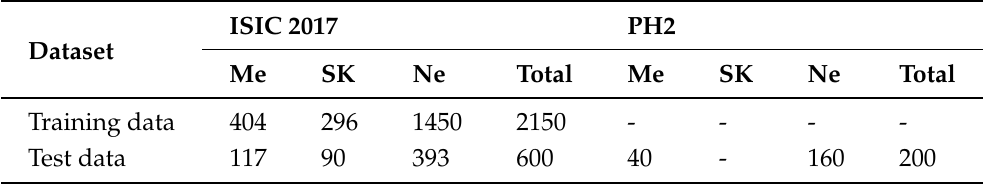
Table 1. The distribution of The ISIC Challenge 2017 data set and PH2